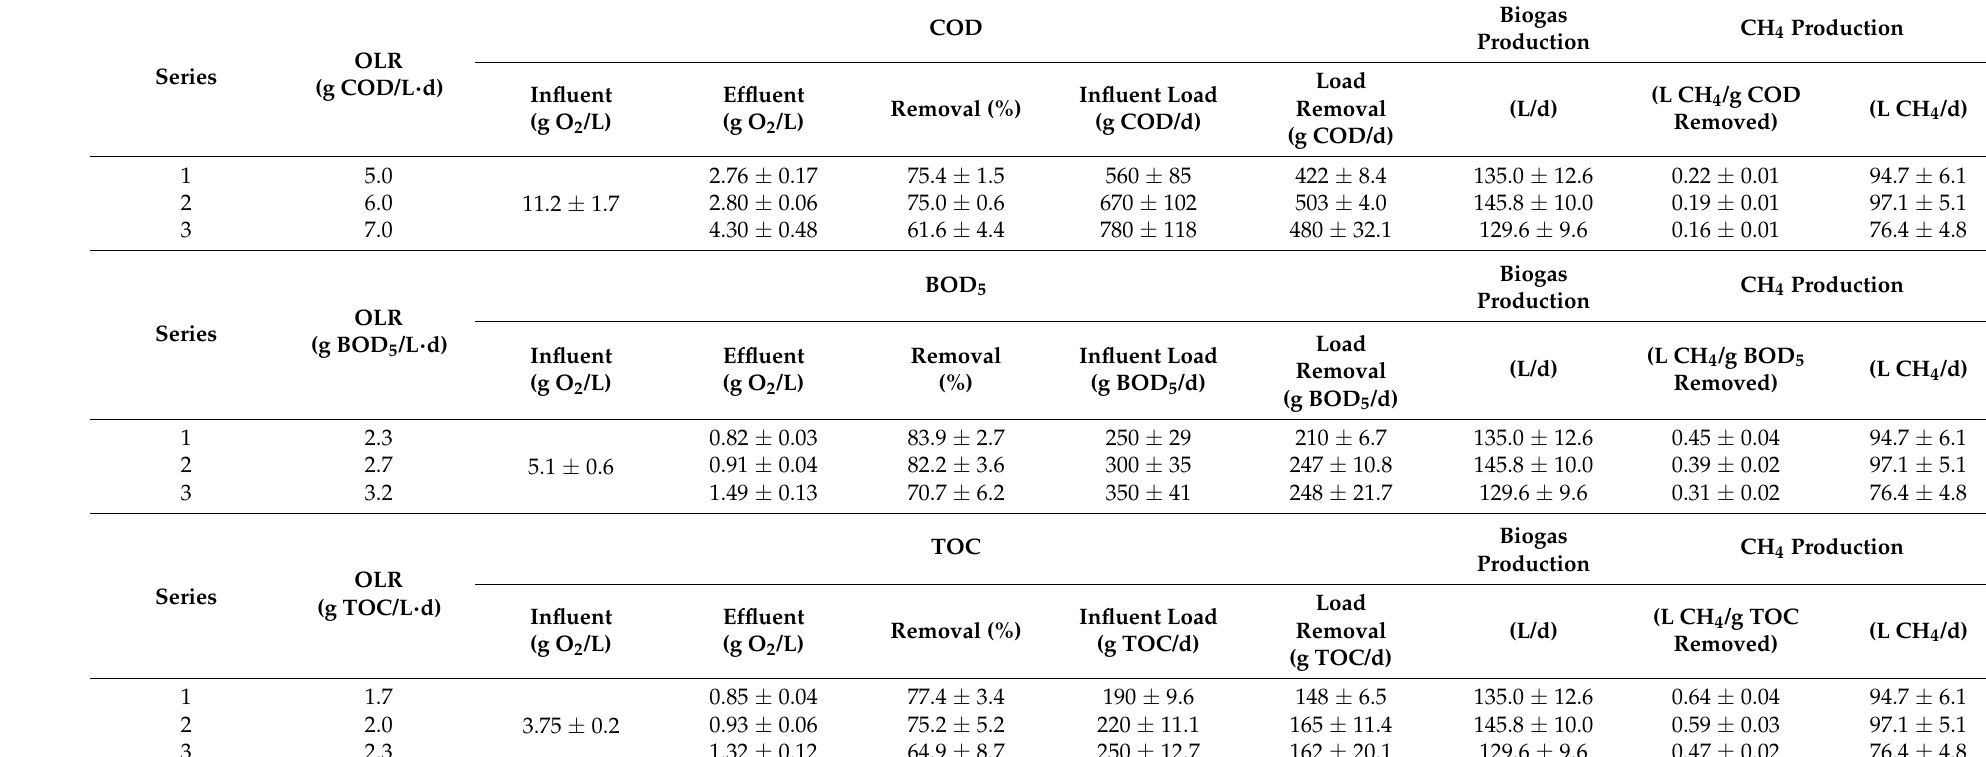
Table 6. Removal of organic compounds such as COD, BOD 5 , TOC, and production of biogas and CH 4 in stage